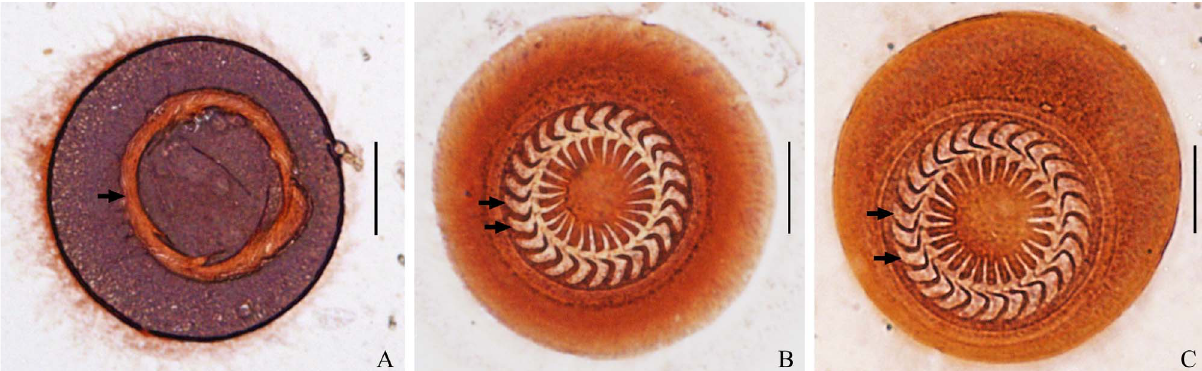
Figure 4. Morphological photomicrographs of the dry silver-impregnated Trichodina unionis from snail Physella acuta (A and B) and snail Gyraulus siamensis (C). (A) Complete-turned ciliature on the oral side (arrow), (B and C) circular arrangement of the denticles within the adhesive disc on the aboral side (arrows point to the bend angle on the blade margin of the denticle). Scale bars: 20 l m.